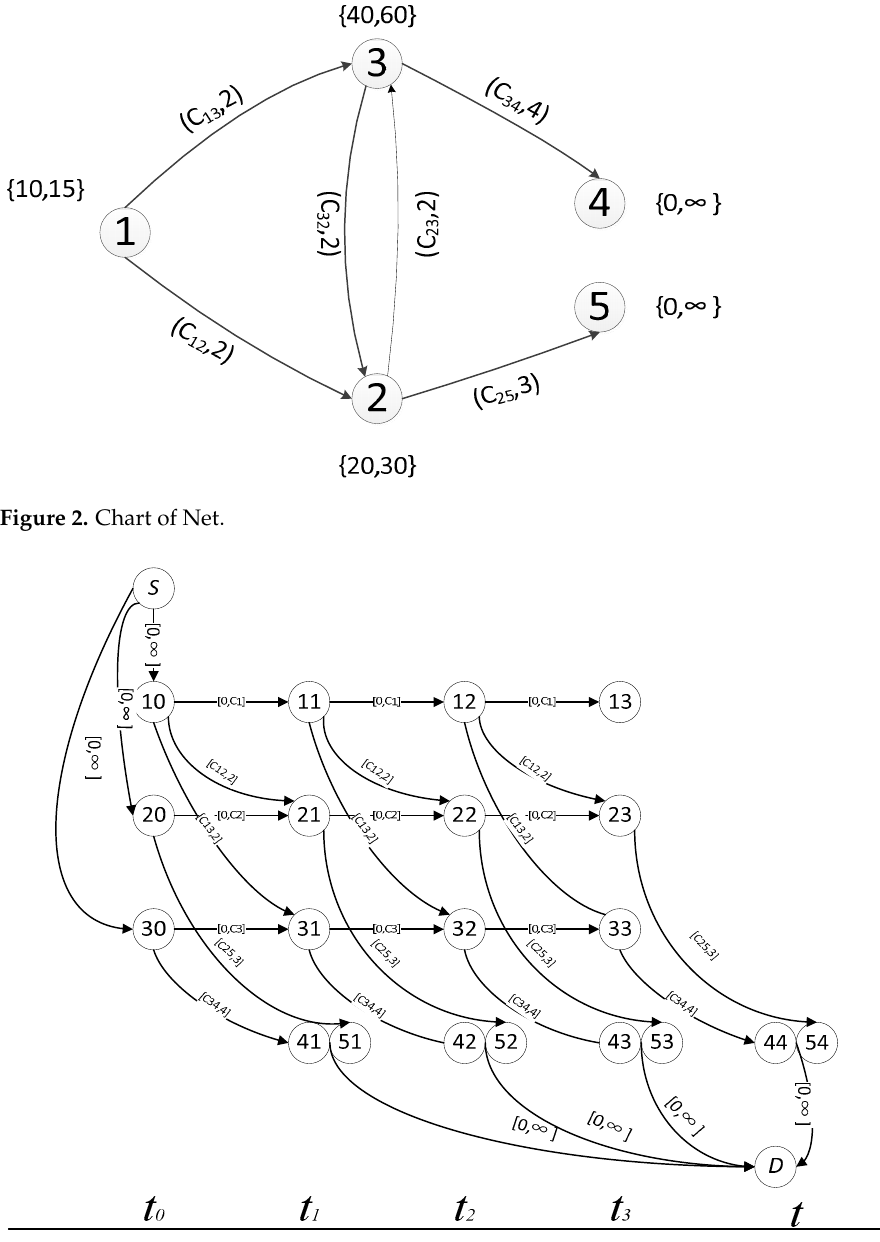
Figure 3. Chart of Multistep Choice in Emergency.